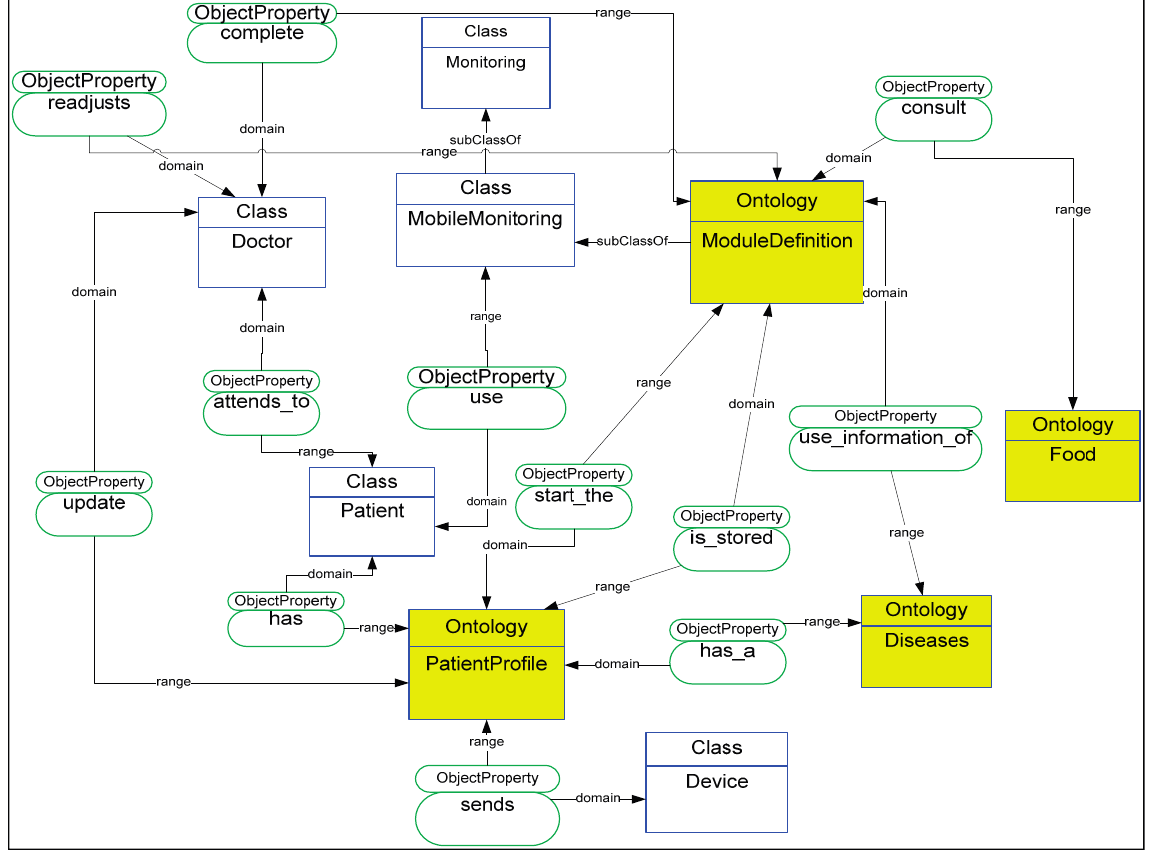
Figure 2. General Ontologies Diagram for mobile monitoring